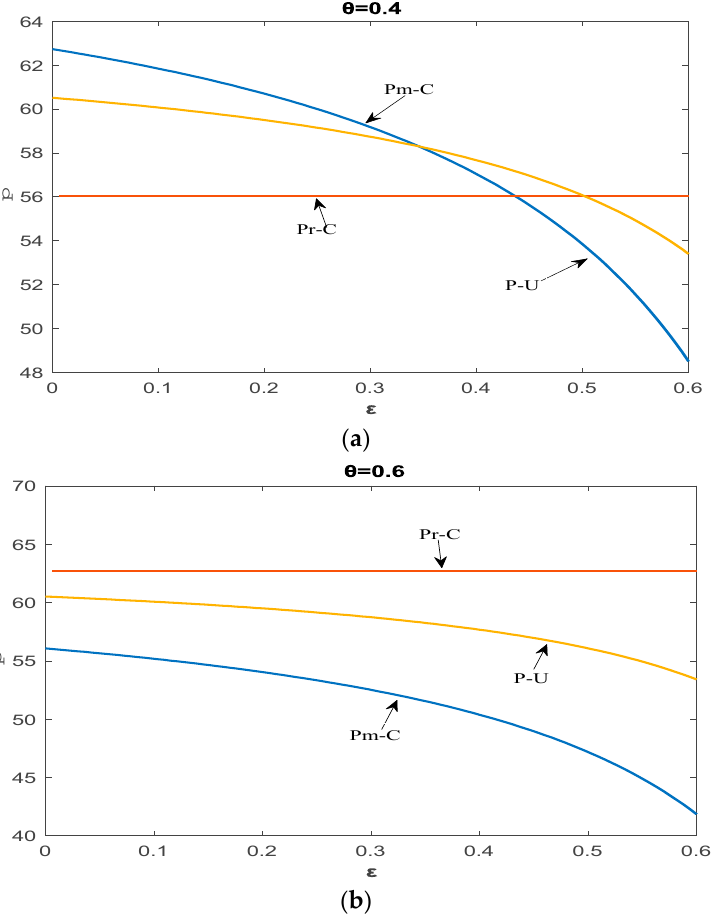
Figure 4. Comparison of pricing in a centralised decision-making model: ( a ) low consumption channel preference 𝜃 and ( b ) high consumption channel preference 𝜃 .